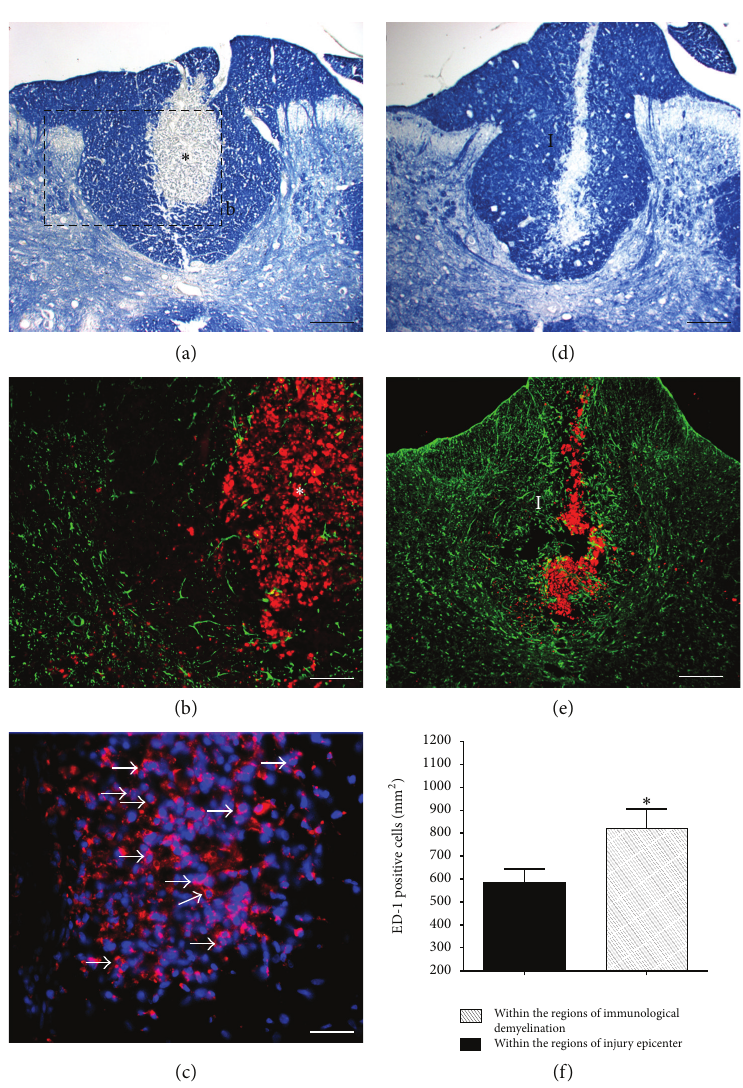
Figure 3: Macrophage-activation antigens (ED-1) 7 days following intraspinal injection of GalC antibodies plus complement proteins or a spinal cord stab injury to the dorsal column. (a) Eriochrome cyanine R-stained transverse section showing the region of immunological demyelination ( ∗ ). (b) Double stained GFAP (green) and ED-1 (red) serial section to (a). The inset highlights the numerous ED-1 positive cells within the region of immunological demyelination (white ∗ ) and the absence of astrogliosis. (c) Localization of ED-1 positive cells (arrows) within the region of immunological demyelination (hatched line). Activated macrophages characterized by their large round cell bodies and their high immunoreactivity for ED-1 are distributed homogeneously throughout the whole region of immunological demyelination. (d) Eriochrome cyanine R-stained transverse section showing the injury site (I). (e) Double stained GFAP (green) and ED-1 (red) serial section to (d). Numerous ED-1 positive cells are present within the injury site bordered by numerous GFAP positive-hypertrophic astrocytes. (f) Quantitative comparisons between the number of ED-1+ cells per mm 2 found within injury epicenters and within regions of immunological demyelination ( ∗ ), 𝑃 < 0.05 . Scale bars: (a), (d), and (e) 200 𝜇 m; (b) and (c) 50 𝜇